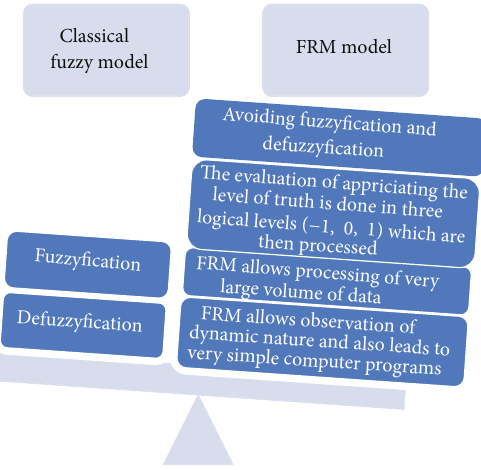
Figure 2: Comparison between the Classical Fuzzy Model and the FRM